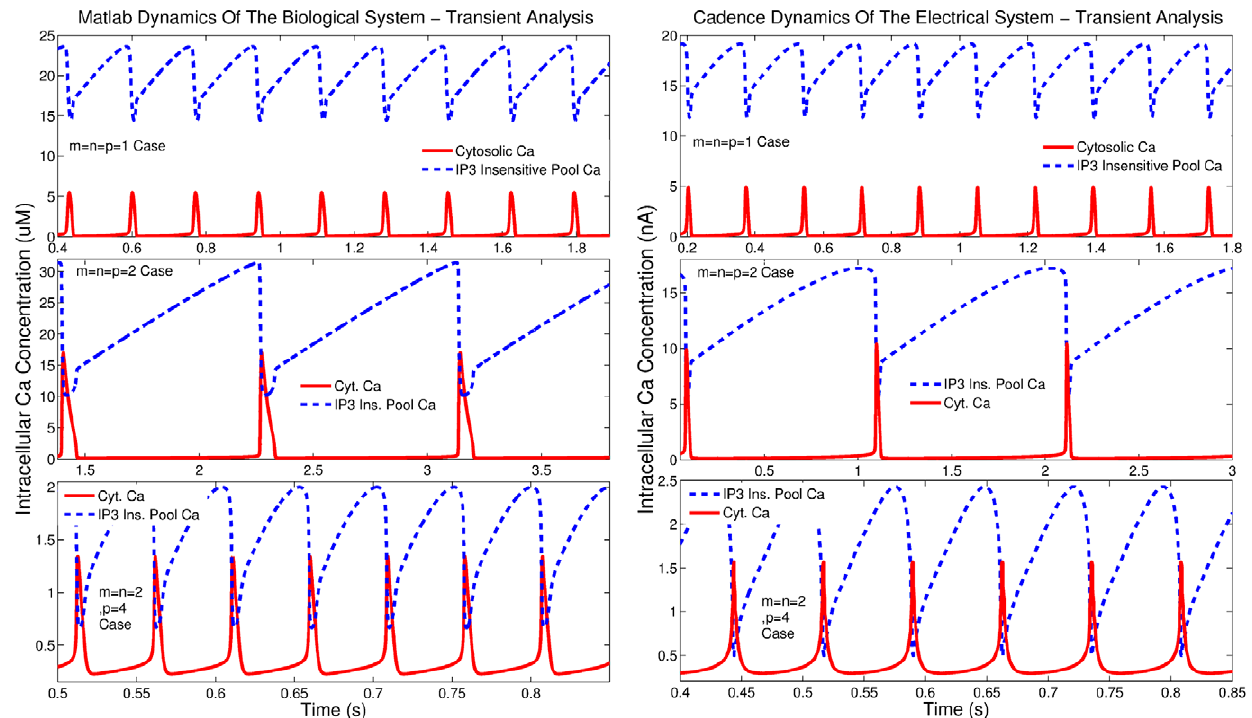
Figure 9. Comparison of transient analysis results generated by MATLAB (cid:2) and Cadence simulations for the Log-Domain intracellular Ca 2 + oscillations circuits.